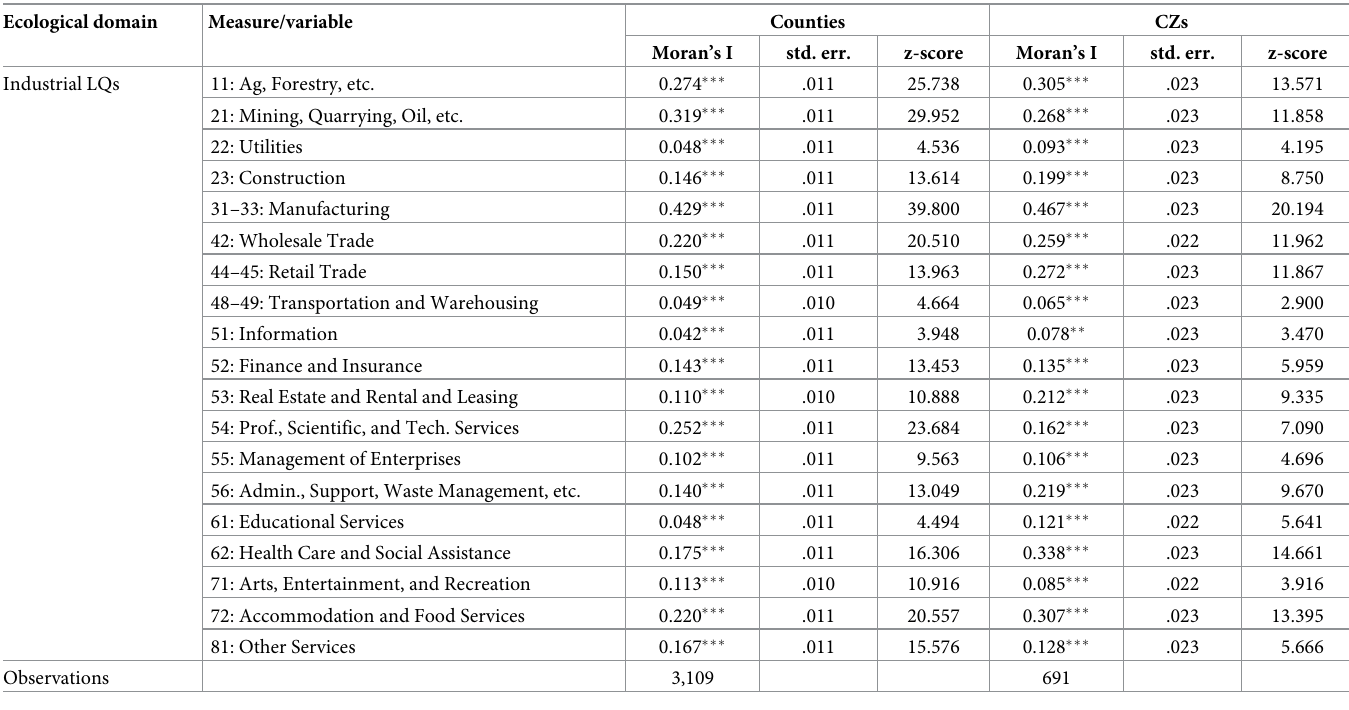
Table 3. Global Moran’s I for industrial LQs (Counties versus CZs). Ecological